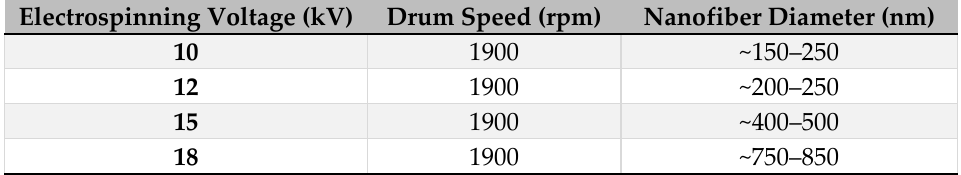
Table 1. Nanofiber diameters electrospun at different electrospinning voltages.